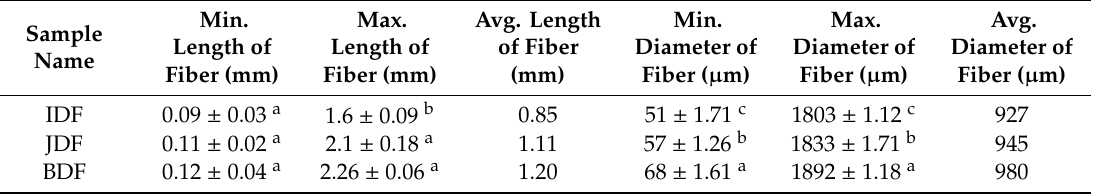
Figure 3. Different dung fiber material exposed upto (500 µm) microscope for easy measurement of average length and diameter. ( a ) Indigenous dung fiber (IDF), ( b ) Jersey cow dung fiber (JDF), ( c ) buffalo dung fiber (BDF). Table 2. Measurement of raw